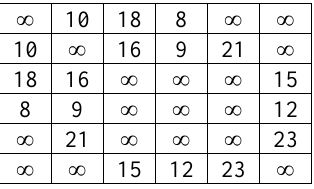
Table 1. The matrix of the weights of the edges